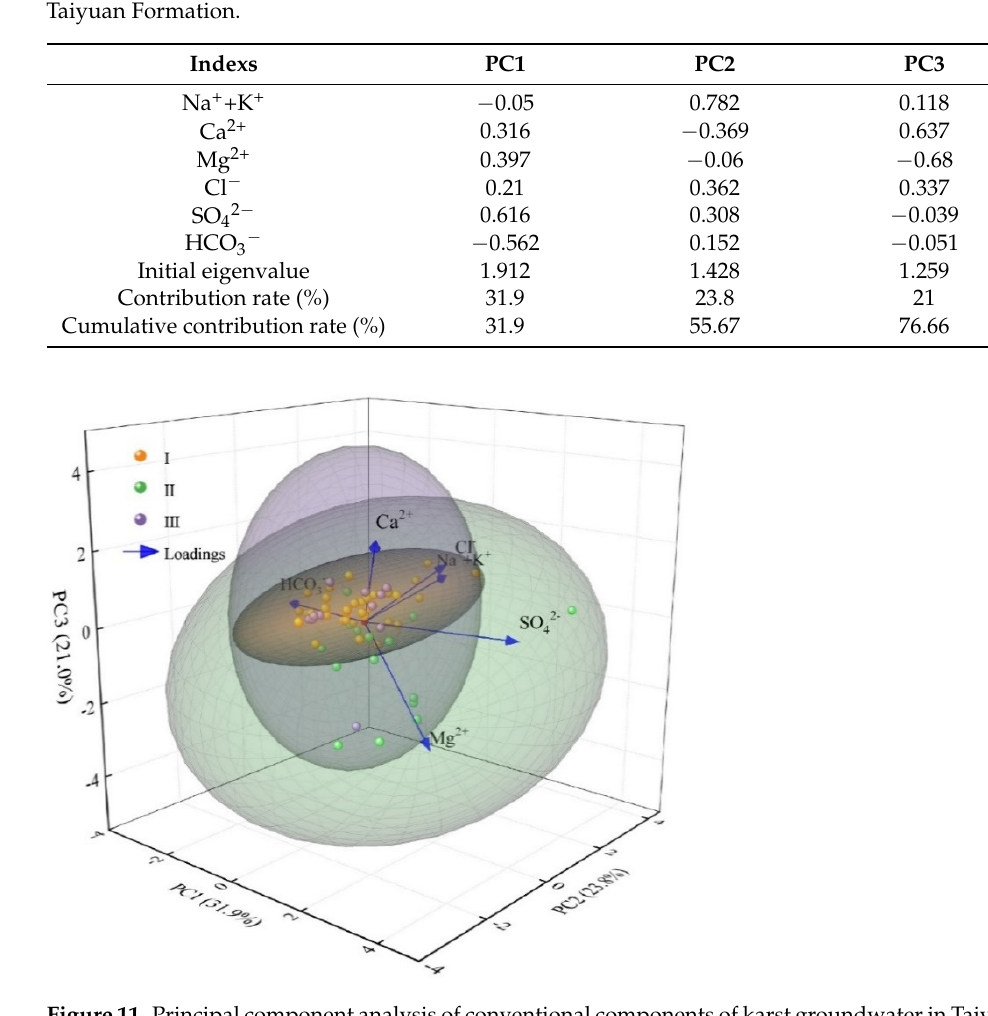
Figure 11. Principal component analysis of conventional components of karst groundwater in Taiyuan Formation.